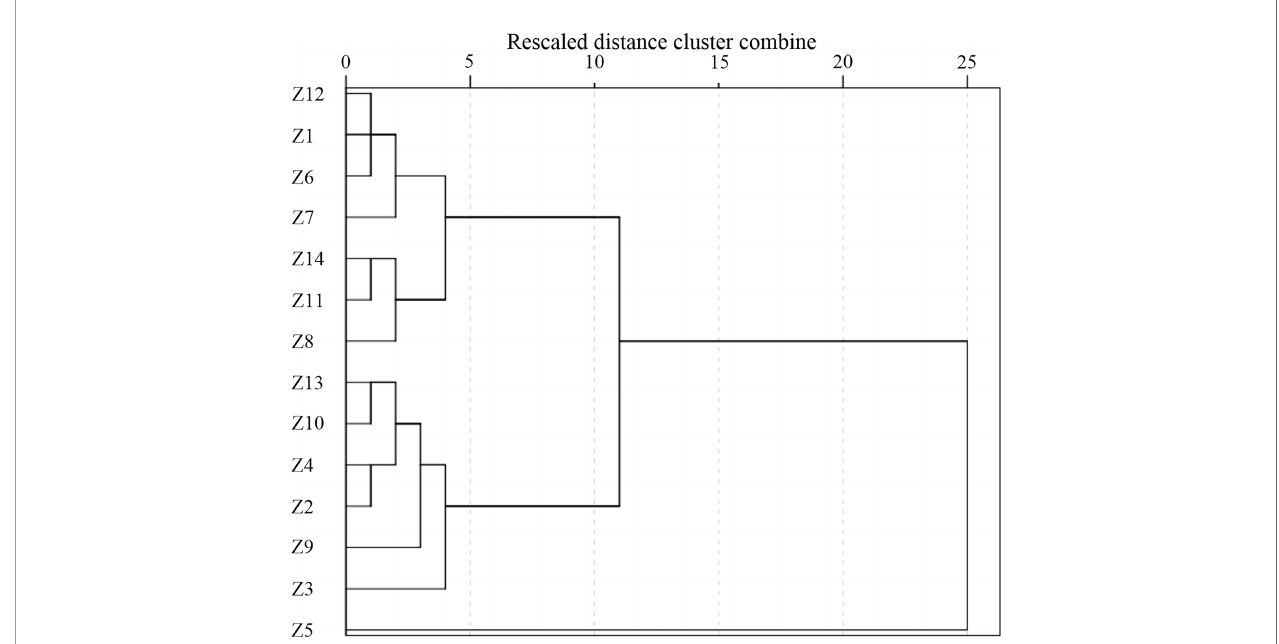
FIGURE 7 | Hierarchical dendrogram in terms of the sampling stations based on the data of contaminant factor in spring and